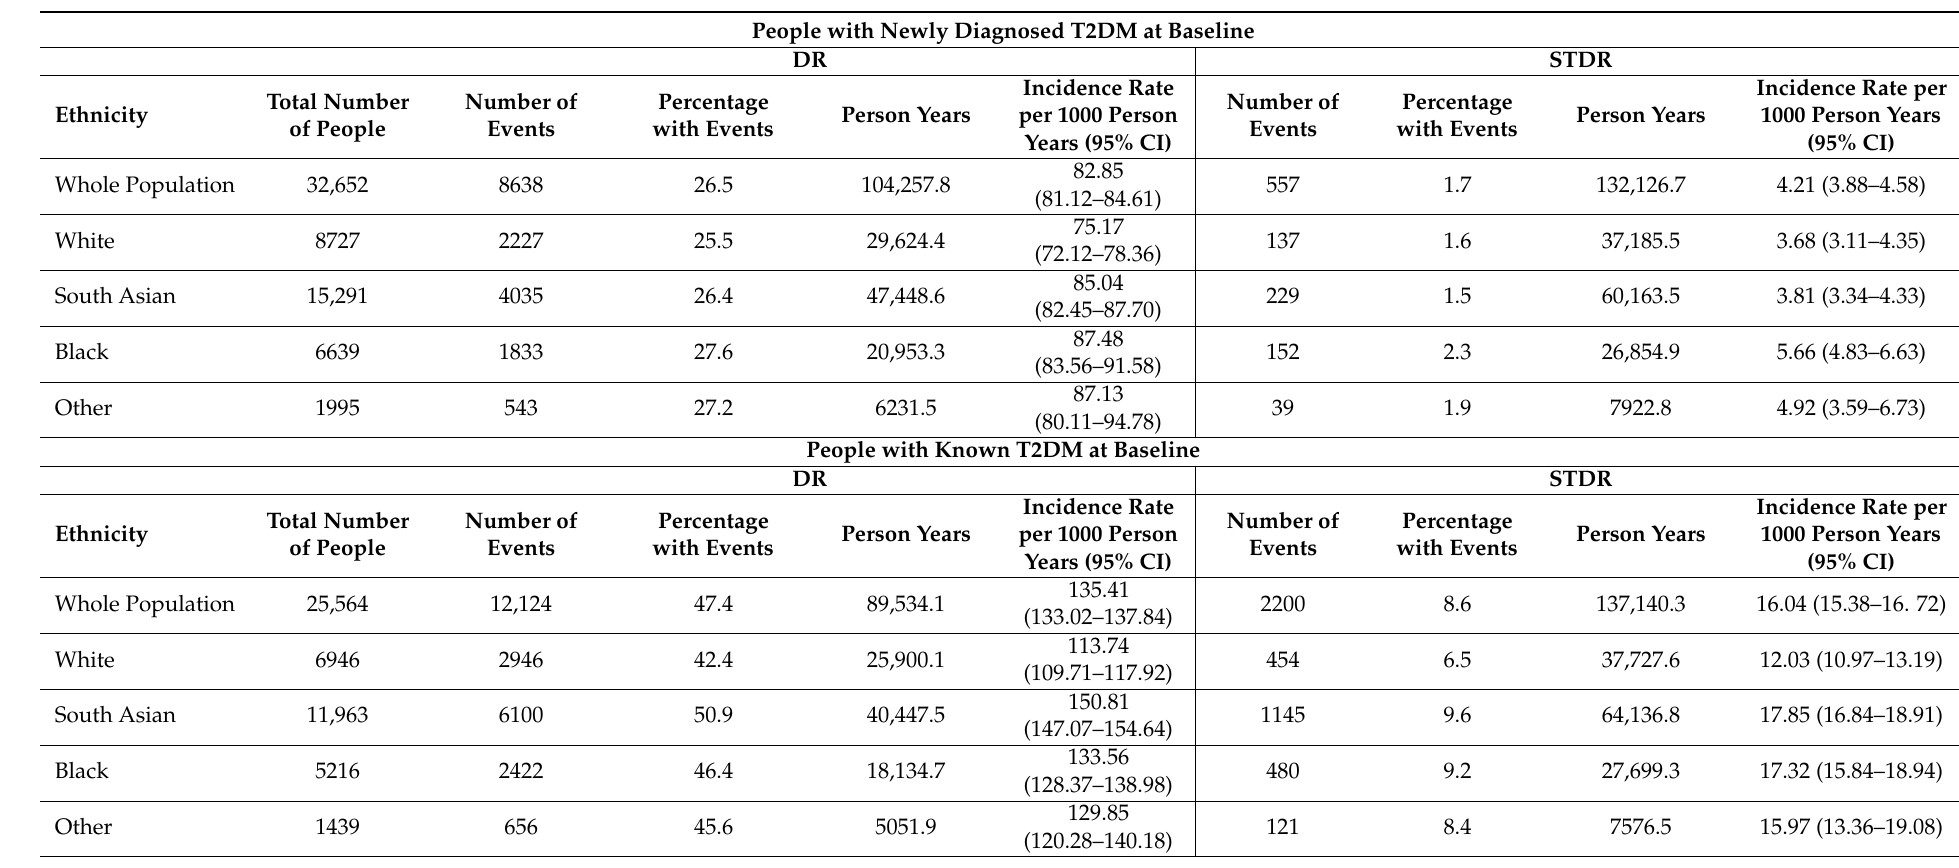
Table 3. Number of incident cases of DR/STDR during 10-year follow-up and incidence rates per 1000 person years in newly diagnosed and known T2DM at